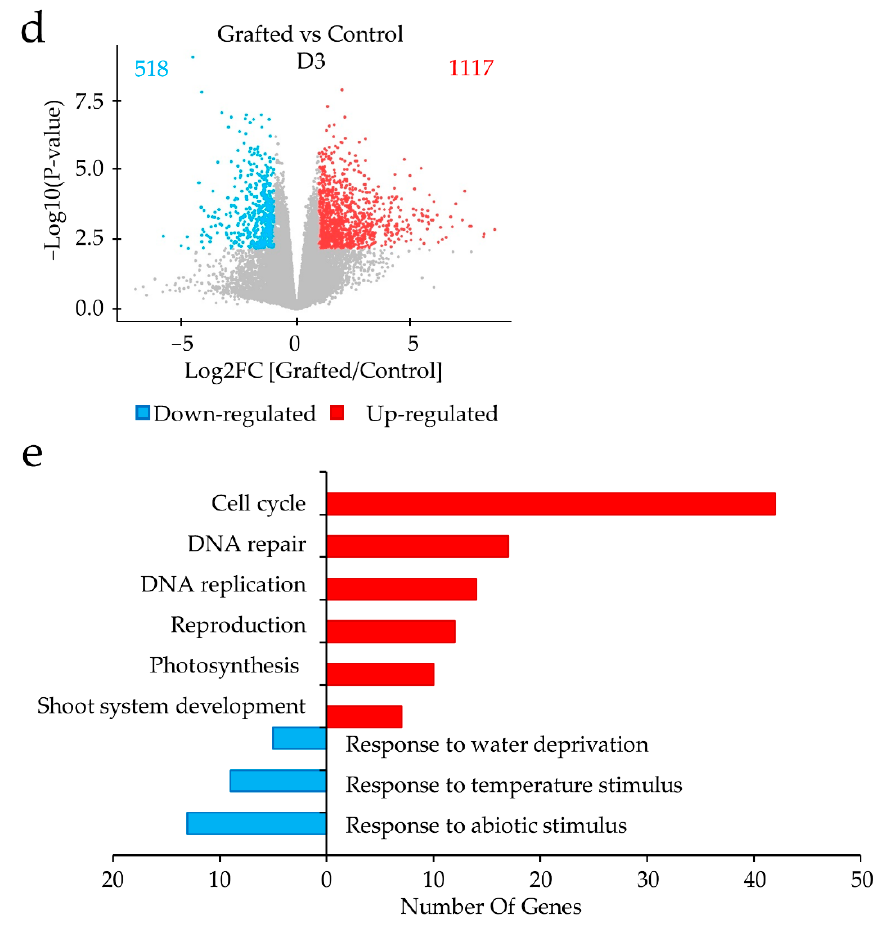
Figure 4. Differentially expressed genes (DEGs) and enriched pathways in grafted and control shoot apical meristem before drought stress and day 3 during stress. Volcano plot representation of DEGs up-regulated and down-regulated by drought stress treatment in ( a ) control and ( b ) grafted samples. The x axis shows logarithm fold change (Log2FC [D3/D0]) and y axis shows –Log10 ( P -value). Significant DEGs (Adj. p < 0.05, Log2FC ≥ |1|) are in red and blue for up-regulation and down-regulation. ( c ) Bar plot showing gene ontology (GO) enrichment analysis (Panther, false discovery rate (FDR) < 0.05) for biological processes on significant DEGs of the control and grafted samples. Empty bars indicate the control and fill bars indicate the grafted samples. The x axis shows the number of genes categorized in each GO term ( y axis). ( d ) Comparison of the DEGs in the grafted and control samples during stress. The x axis shows logarithm fold change (Log2FC [Grafting/Control]) and y axis shows –Log10 ( p -value). ( e ) Bar plot showing GO enrichment analysis (Panther, FDR < 0.05) for biological process in DEGs by the grafted samples. Red and blue color indicate higher and lower gene expression on significant DEGs (Adj. p < 0.05, Log2FC ≥ |1|). The x axis shows the –Log10 ( p -value) categorized in each GO term ( y axis).